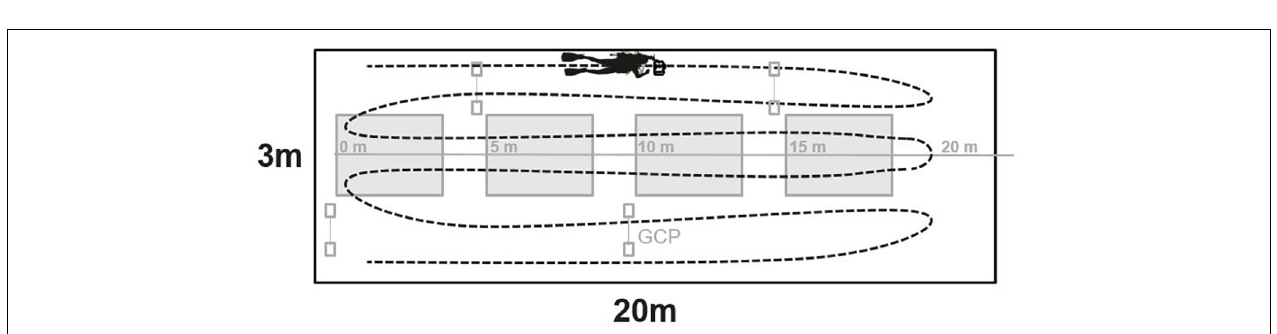
FIGURE 1 | Location of 104 survey sites (pink and yellow), sites with 28 repeated surveys indicated in pink. White outlines and labels indicate sub-island sectors.